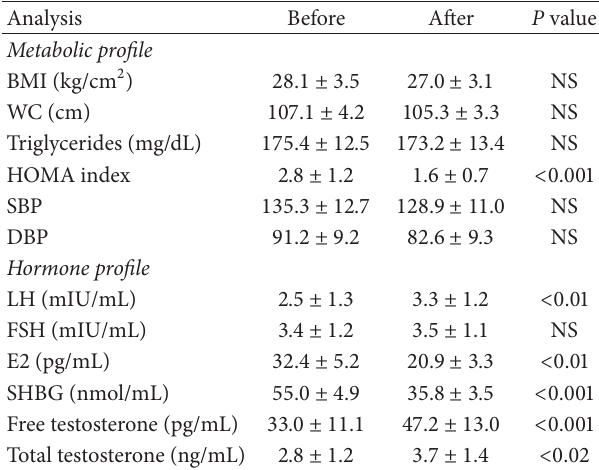
Table 1: Metabolic and hormone profiles before and after treatment. Analysis